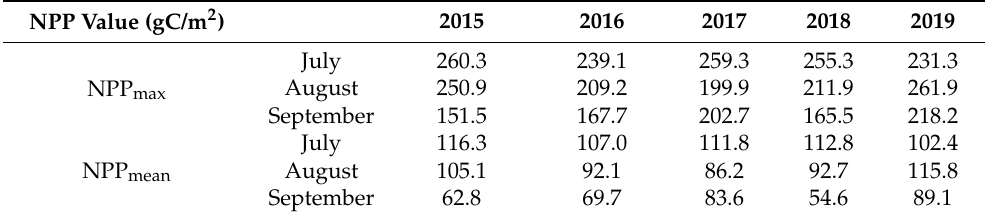
Table 2. The estimated values of NPP based on the CASA model in the study region in July, August and September 2015 to